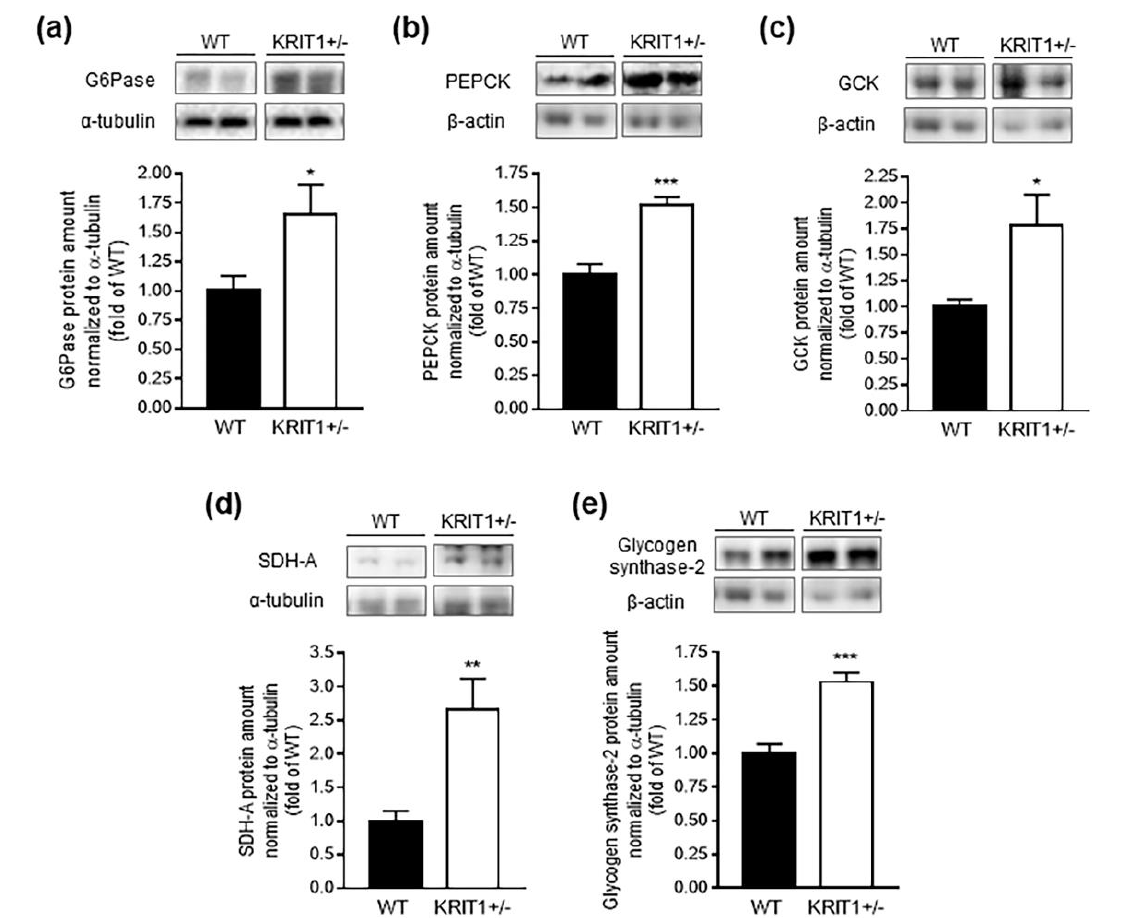
Figure 4. KRIT1 haploinsufficiency affected major regulatory proteins implicated in hepatic glucose metabolism. ( a – e ) Representative Western blots and related histograms showing the increased expression levels of key enzymes involved in gluconeogenesis [glucose 6-phosphatase (G6Pase) ( a ) and phosphoenolpyruvate carboxykinase (PEPCK) ( b )], glycolysis [glucokinase (GCK) ( c )], mitochondrial energy metabolism [succinate dehydrogenase A (SDH-A) ( d )], and glycogen synthesis [glycogen synthase-2 (GYS2) ( e )] in liver homogenates from KRIT1 +/ − mice vs. WT littermate controls. The histograms represent the densitometric quantification of protein bands of 7 mice per group normalized to the corresponding loading control (α -tubulin). Data are means ± SEM of 7 mice per group and are presented as fold changes relative to the WT control. * p < 0.05; ** p < 0.005; *** p < 0.001 vs. WT.